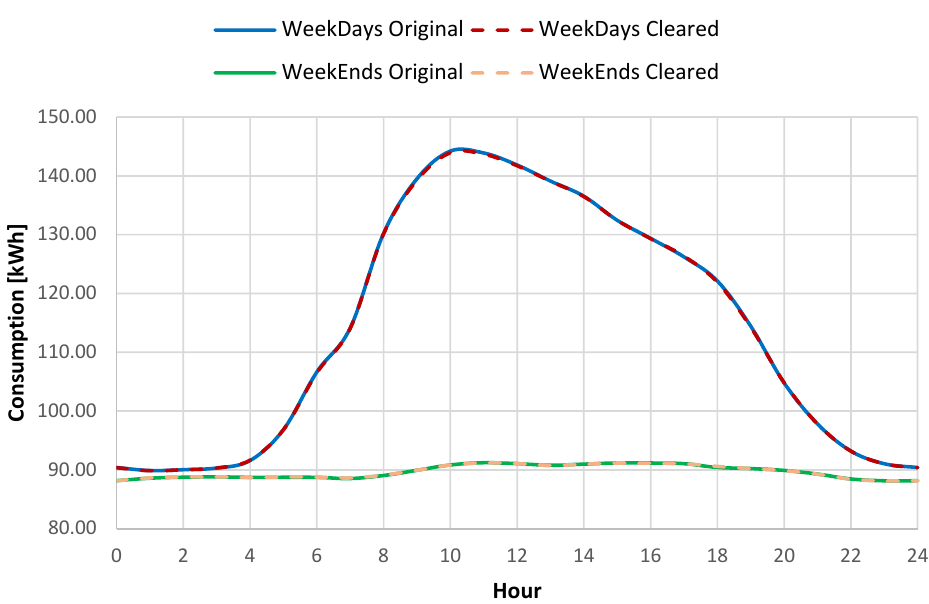
Figure 13. Energy consumption variation range compared to hourly average weekends consumption for original and cleared data sets.